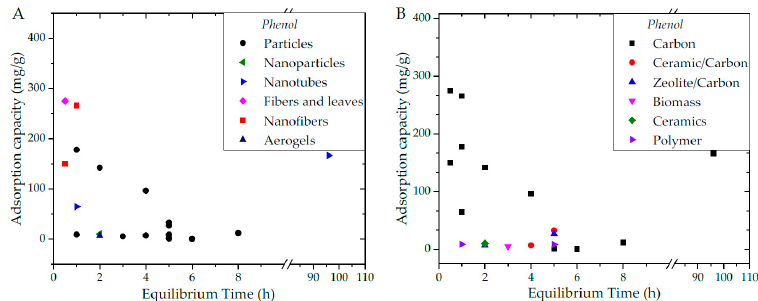
Figure 8. Adsorption performance related to the adsorption test equilibrium time against Phenol, for several adsorbents structures ( A ) and compositions ( B ).